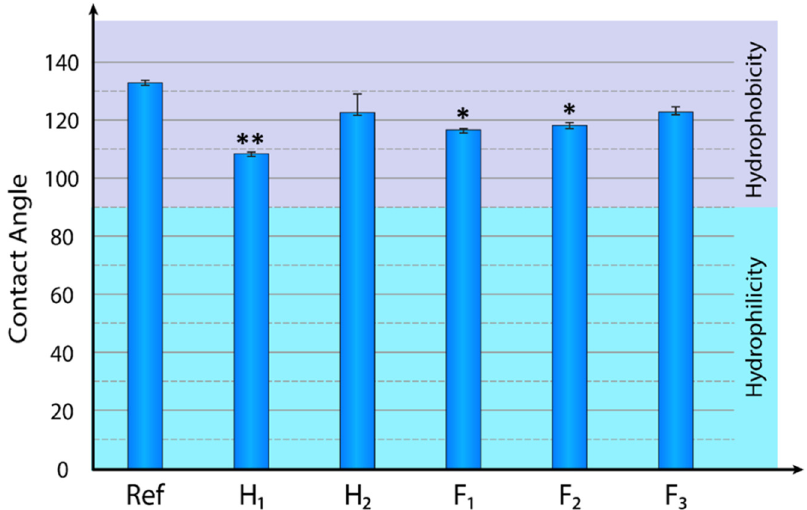
Figure 2. Measurement of static contact angle of a water droplet on a solid surface of electrospun nanofibers of pure PCL spotted as Ref and its blends containing HAp, noted as H1—1% ( w / v ) and H2—3% ( w / v ); FAp noted as F1—1% ( w / v ), F2—3% ( w / v ), F3—7% ( w / v ), respectively. Data are presented as mean ± SD ( n = 5). p -values were calculated based on t-test. Asterisks show the significance levels of difference for particular variants versus Ref (pure PLC): ** for p < 0.01; * for p < 0.05.